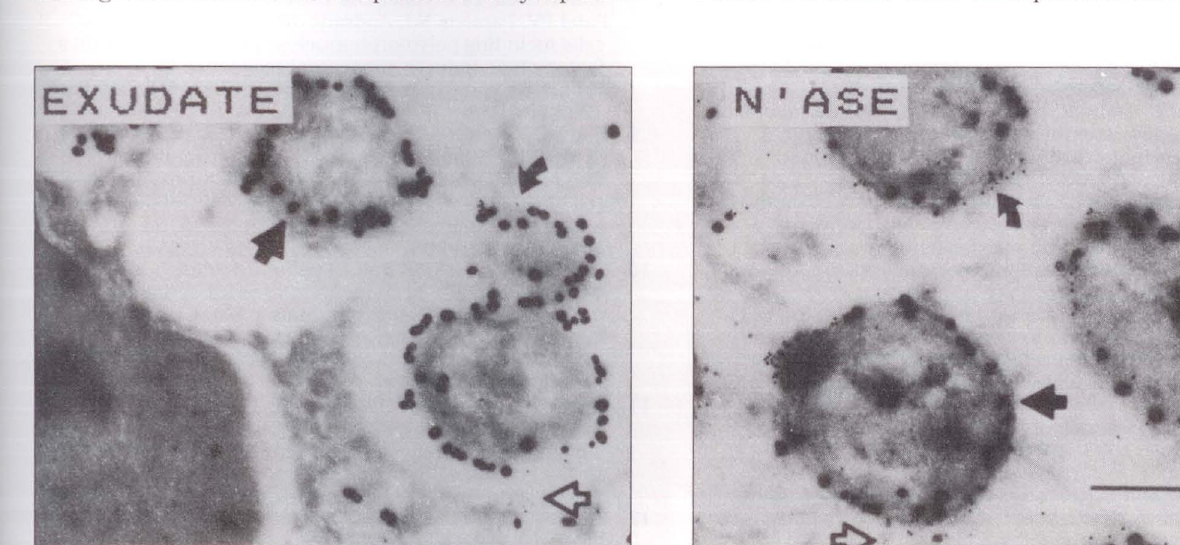
Figure 6a) ControL Results ofimmunogold labeling e.A-periments with urethral exudate. Very small gold particles (indicated by the open arrows) denote the initial reaction with the monoclonal antibody (MAb); this is minimal in the controL The very large _ particles (indicated by the straight solid arrows) show that the cocci are gonococci by reaction with a specific antiserum. The intermediate sized particles indicated by the curved solid arrows show the reaction with the MAb after incubation with medium tion with